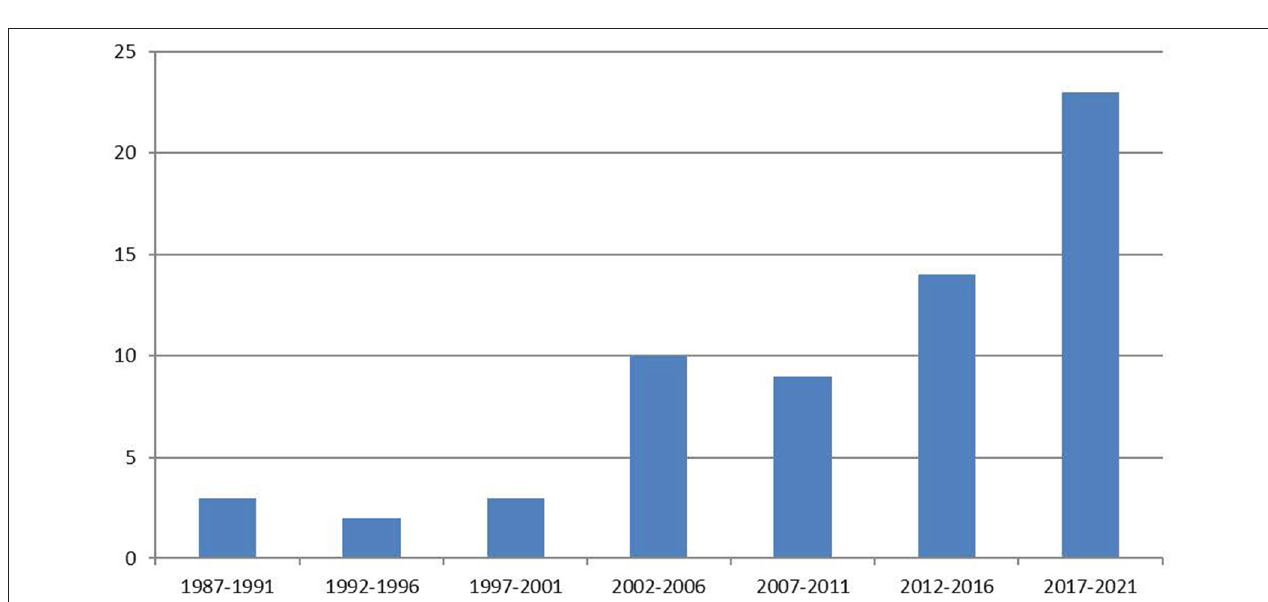
FIGURE 2 | Number of Working Alliance Inventory measurement properties studies over